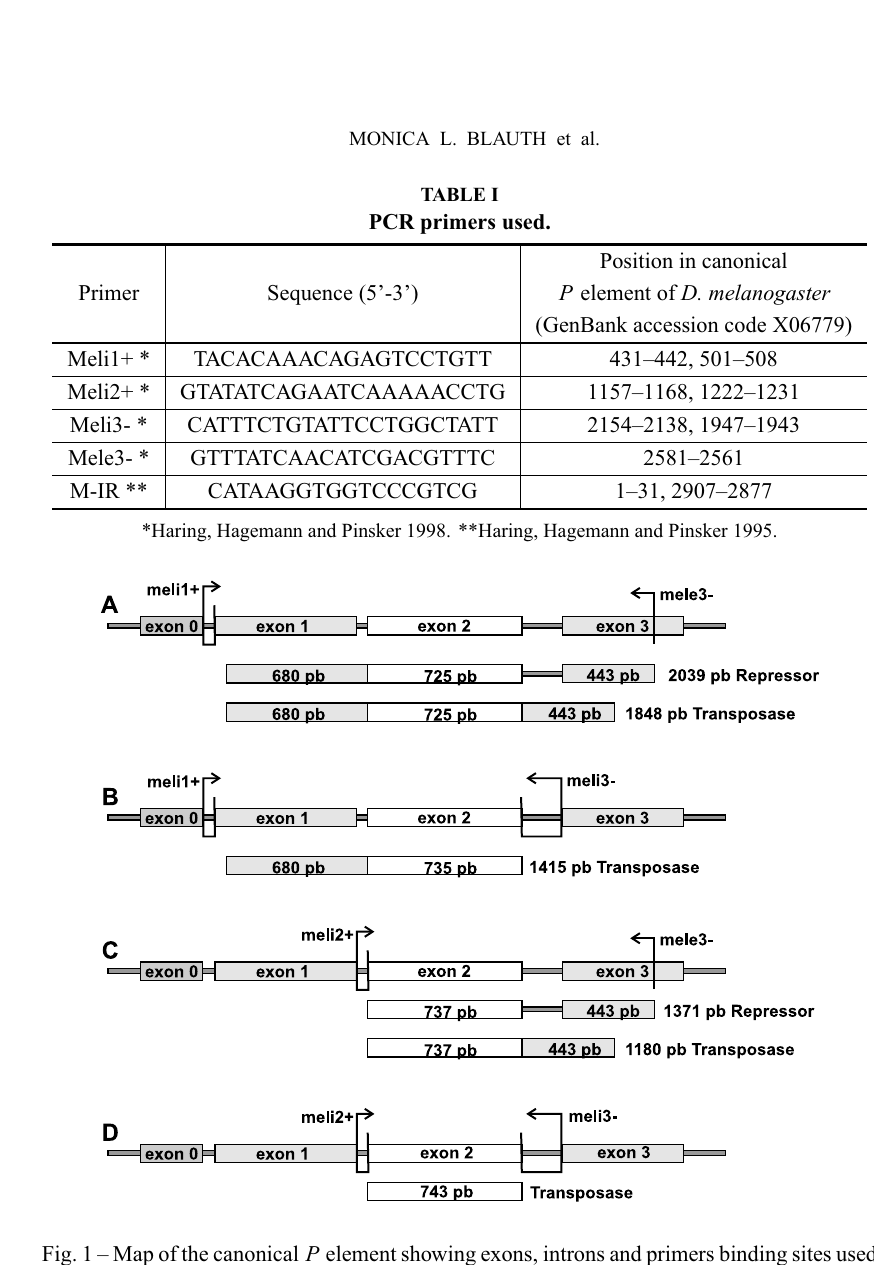
Fig. 1 – Map of the canonical P element showing exons, introns and primers binding sites used inRT-PCR.(A)meli1+andmele3-primerbindingsitesandtheprobablefragmentsamplifiedin RT-PCR amplification. (B) meli1+ and meli3- primer binding sites and the probable fragments amplified in RT-PCR amplification. (C) meli2+ and mele3- primer binding sites and the probable fragments amplified in RT-PCR amplification. (D) meli2+ and meli3- primer binding sites and the probable fragments amplified in RT-PCR